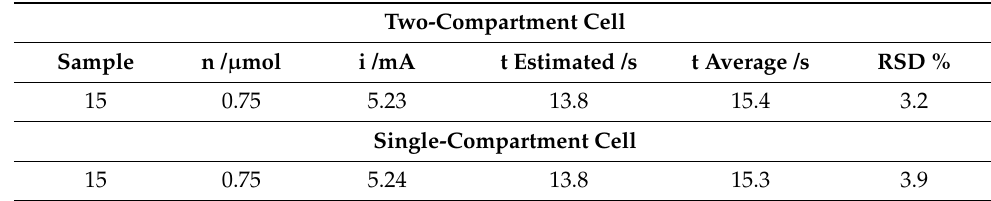
Table 2. Summary of the initial acid/base titrations.